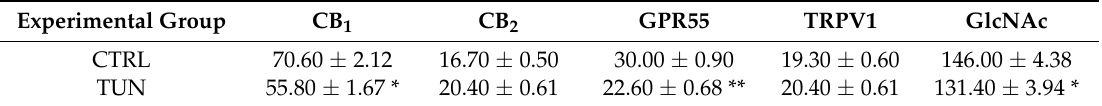
Table 1. Mean fluorescent intensity (MFI) values of SH-SY5Y cells expressing eCB-binding receptors, and GlcNAc residues. * Denotes p < 0.001; ** p < 0.05.